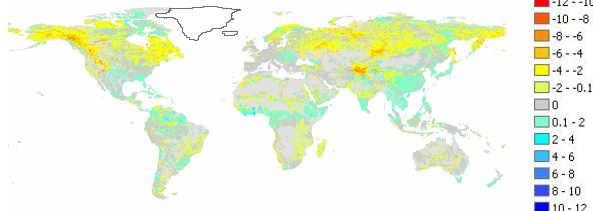
Fig. 8. Maps showing the number of models projecting change in timing of the annual cycle consistent with the ensemble mean di- rection of change of timing. The negative numbers correspond to the number of models projecting advances in the annual cycle con- sistent with the ensemble mean advances, positive numbers corre- spond to consistent projected delays in the timing of regime, grey areas correspond to regions with zero